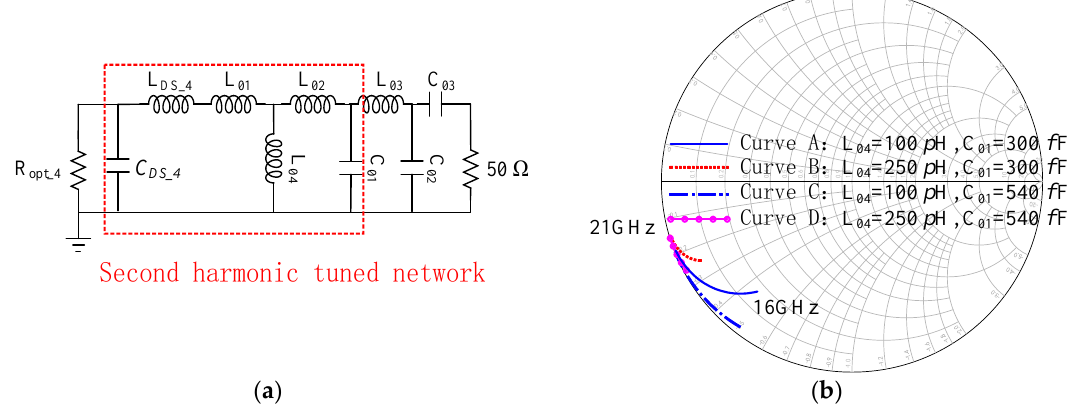
Figure 5. ( a ) The schematic of the output matching network; ( b ) the responses of second-harmonic load impedance versus L 04 and C 01